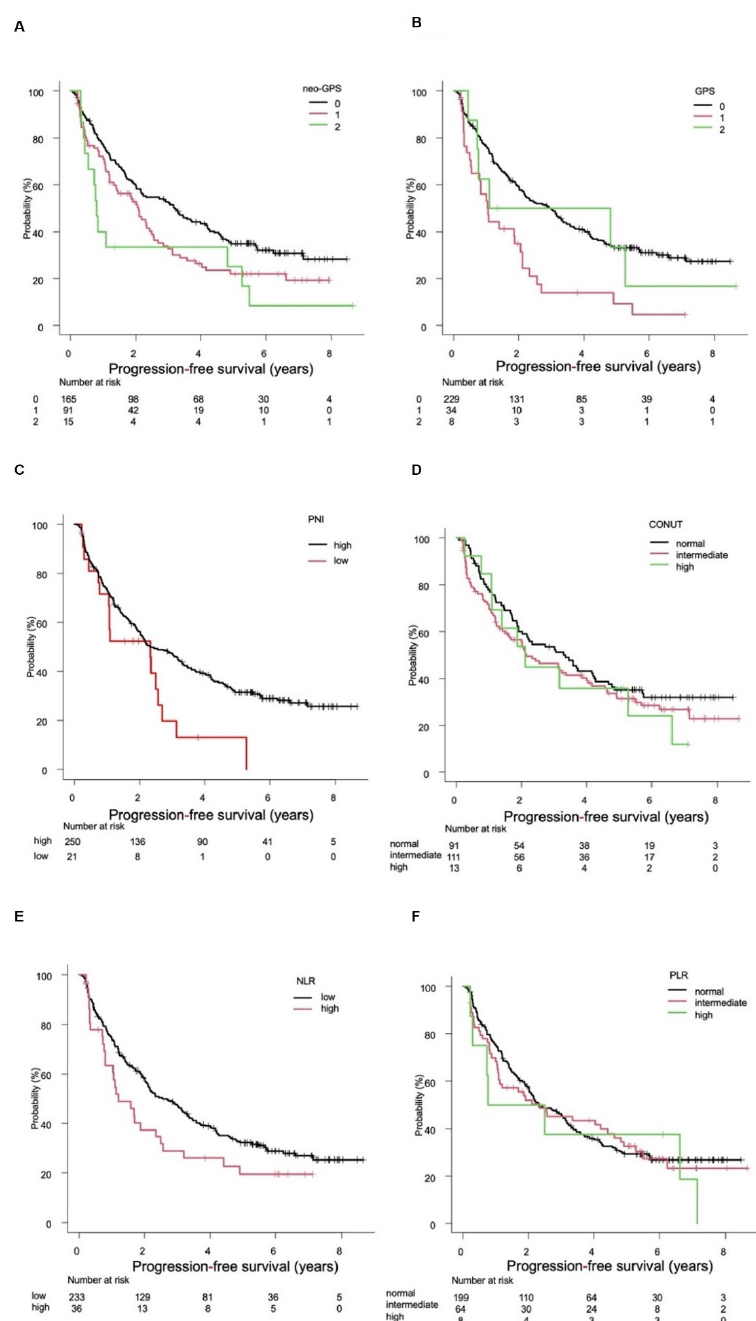
Figure 2. Progression-free survival (PFS) according to assessment tool. ( A ) The median PFS (mPFS) rates were 3.2 (95%CI 2.1–4.2), 2.1 (95%CI 1.3–2.5), and 0.8 (95%CI 0.4–4.8) years in patients with neo- GPS of 0, 1, and 2, respectively ( p = 0.009). ( B ) The mPFSs were 3.0 (95%CI 2.2–3.5), 1.0 (95%CI 0.5–2.0), and 3.0 (95%CI 0.4–NA) years in patients with GPSs of 0, 1, and 2, respectively ( p < 0.001). ( C ) The mPFSs were 2.3 (95%CI 2.0–3.3) and 2.3 (95%CI 0.8–2.6) years in patients with high (>40) and low ( ≤ 40) PNIs, respectively ( p = 0.034). ( D ) The mPFSs were 3.3 (95%CI 1.9–4.2), 2.1 (95%CI 1.5–3.9), and 2.1 (95%CI 1.1–6.6) years in patents with normal, intermediate, and high controlling nutritional status scores, respectively ( p = 0.426). ( E ) The mPFSs were 2.5 (95%CI 2.0–3.3) and 1.2 (95%CI 0.8–2.5) years in patients with low (<4.0) and high ( ≥ 4.0) neutrophil/lymphocyte ratios, respectively ( p = 0.065). ( F ) The mPFSs were 2.3 (95%CI 2.0–3.2), 2.3 (95%CI 1.1–4.6), and 1.6 (95%CI 0.2–NA) years in patients with normal, intermediate, and high platelet/lymphocyte ratios, respectively ( p =